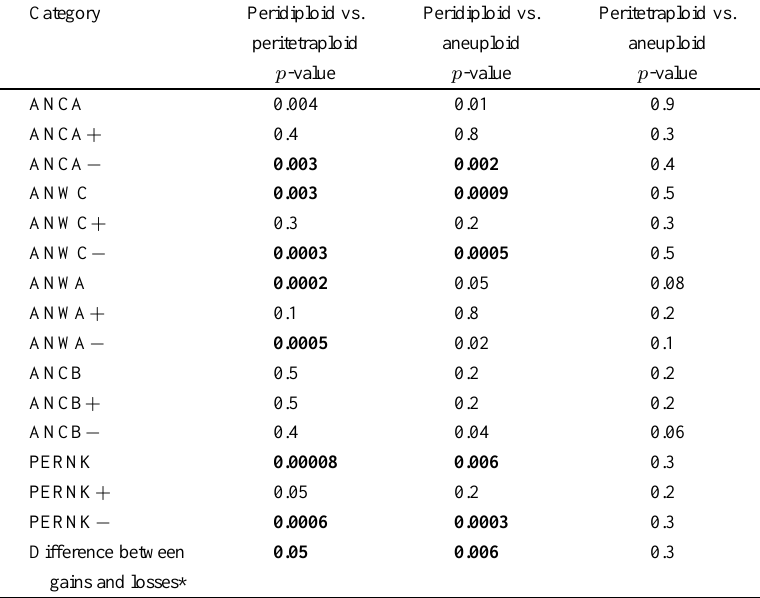
Results of the statistical analysis of the number of imbalances by the t -test (by Student) Category Peridiploid vs. Peridiploid vs. Peritetraploid vs. peritetraploid aneuploid aneuploid p -value p